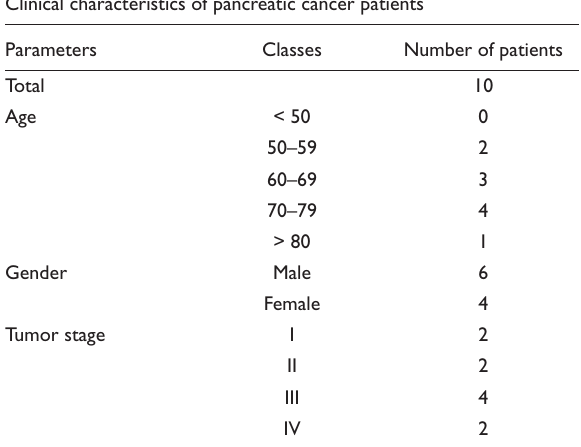
Table 1. The list of clinical characteristics of pancreatic cancer patients ( n = 10) enrolled in this